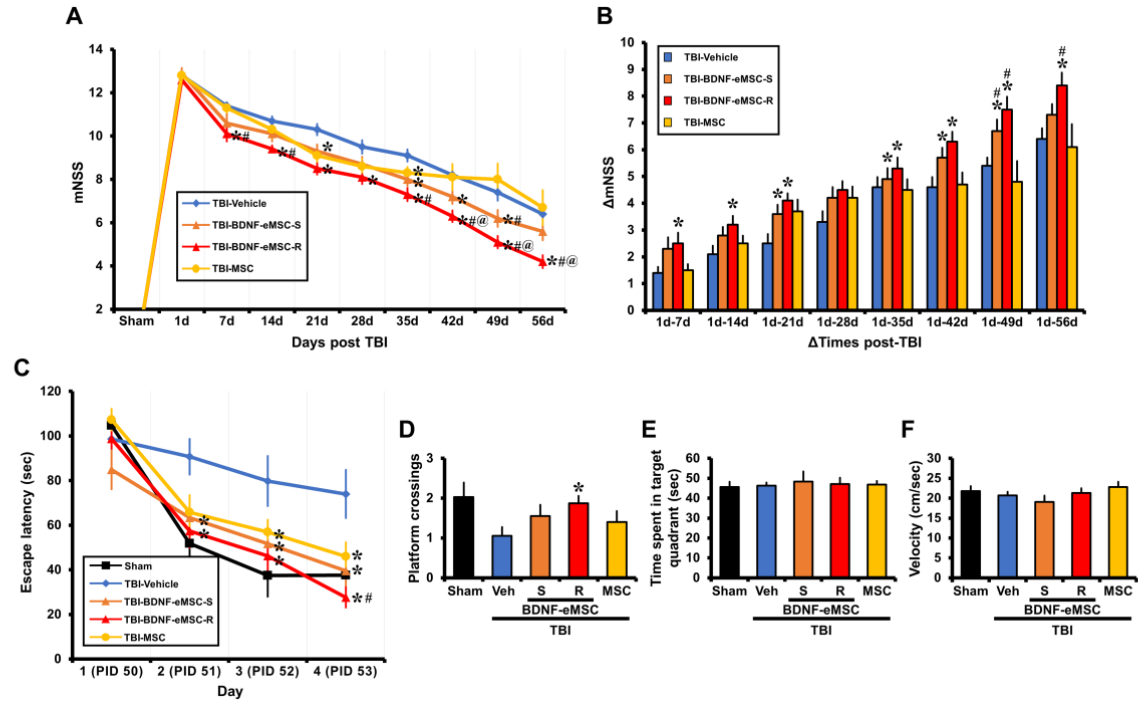
Figure 7. Behavioral effects of repeated administration of BDNF-eMSCs after TBI. ( A ) The mNSS was determined in rats for the entire experiment period after TBI. A score of 18 means that all tasks failed; a score of 0 indicates that all tasks were successfully completed. Data are mean ± SEM; n = 10 from each group, * p < 0.05 vs. vehicle-treated group, # p < 0.05 vs. MSC-treated group, @ p < 0.05 vs. single BDNF-eMSCs (BDNF-eMSC-S)-treated group (Repeated measure ANOVA; Day: F = 238.907, p < 0.001; Group: F = 8.806, p < 0.001; Day × Group interaction: F = 2.405, p < 0.001). ( B ) Changes in mNSS (ΔmNSS) were evaluated at various time intervals between day 1 and multiple pre -deter- mined time points thereafter. Data are mean ± SEM; n = 10 from each group, * p < 0.05 vs. vehicle- treated group, # p < 0.05 vs. MSC-treated group (Repeated measures ANOVA; Time: F = 74.780, p <